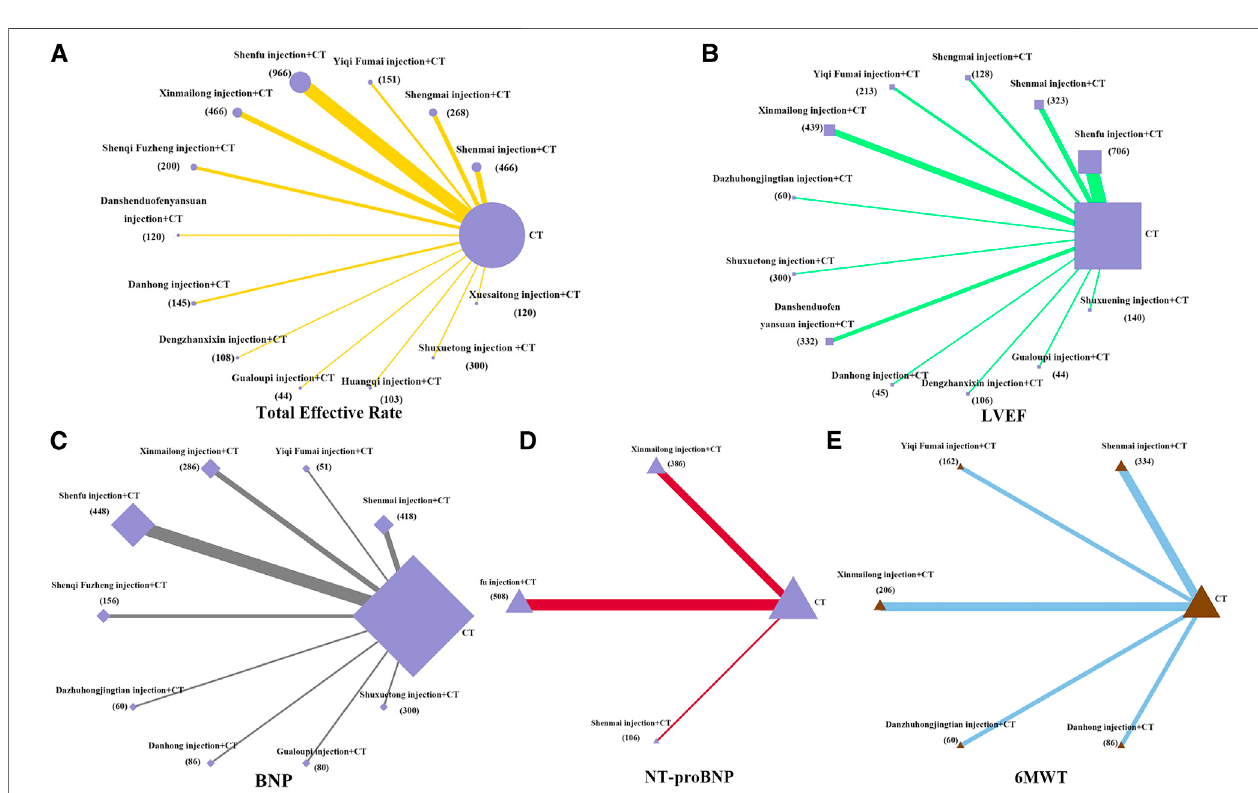
FIGURE 3 | Network diagrams of comparisons on different outcomes of treatments in different groups of patients with CHD-HF. (A) total effective rate; (B) LVEF; (C) BNP; (D) NT-proBNP; (E) 6MWT. Each node represents a type of treatment. The node size is proportional to the total number of patients receiving a treatment (in brackets). Each line represents a type of head-to-head comparison. The width of lines is proportional to the number of trials comparing the connected treatments.